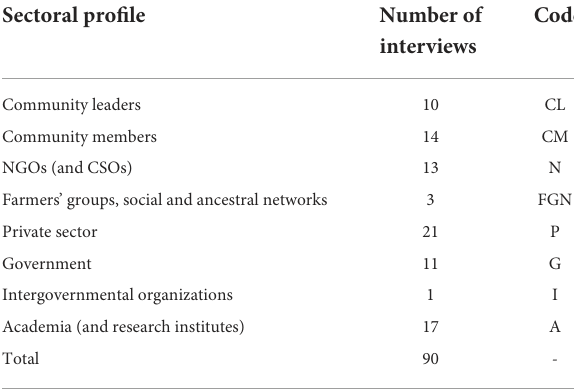
TABLE 3 Sectoral profiles of in-depth and semi-structured interviews (source: